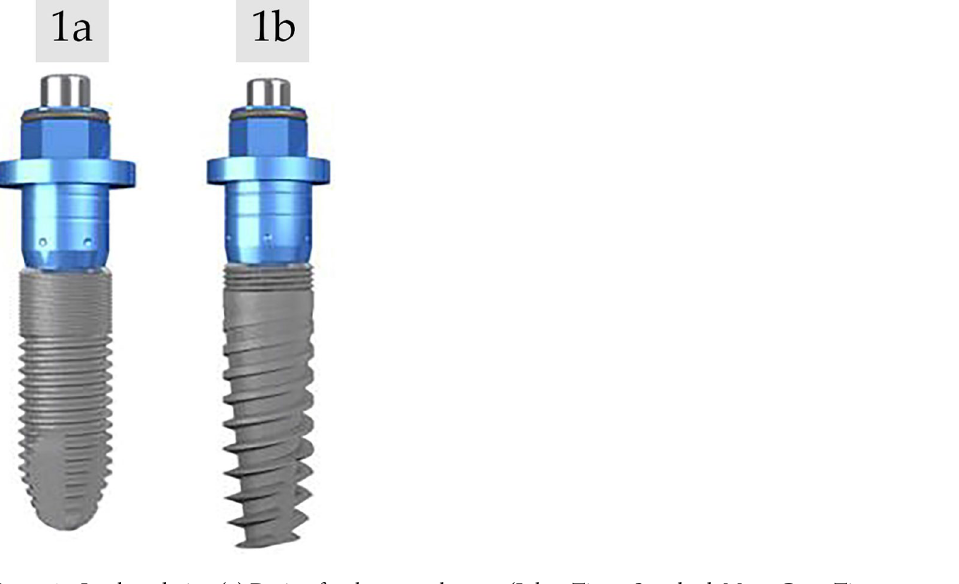
Figure 1. Implant design ( a ) Design for the control group (Inhex Ticare Standard, Mozo Grau, Ticare, Valladolid, Spain); ( b ) Design for the experimental group (Inhex Quattro Ticare, Mozo Grau, Ticare, Valladolid,